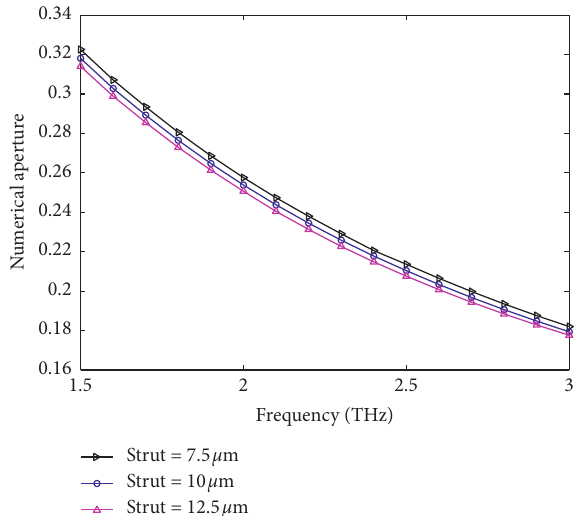
Figure 10: Depiction of the numerical apertures in the THz band for the three dissimilar